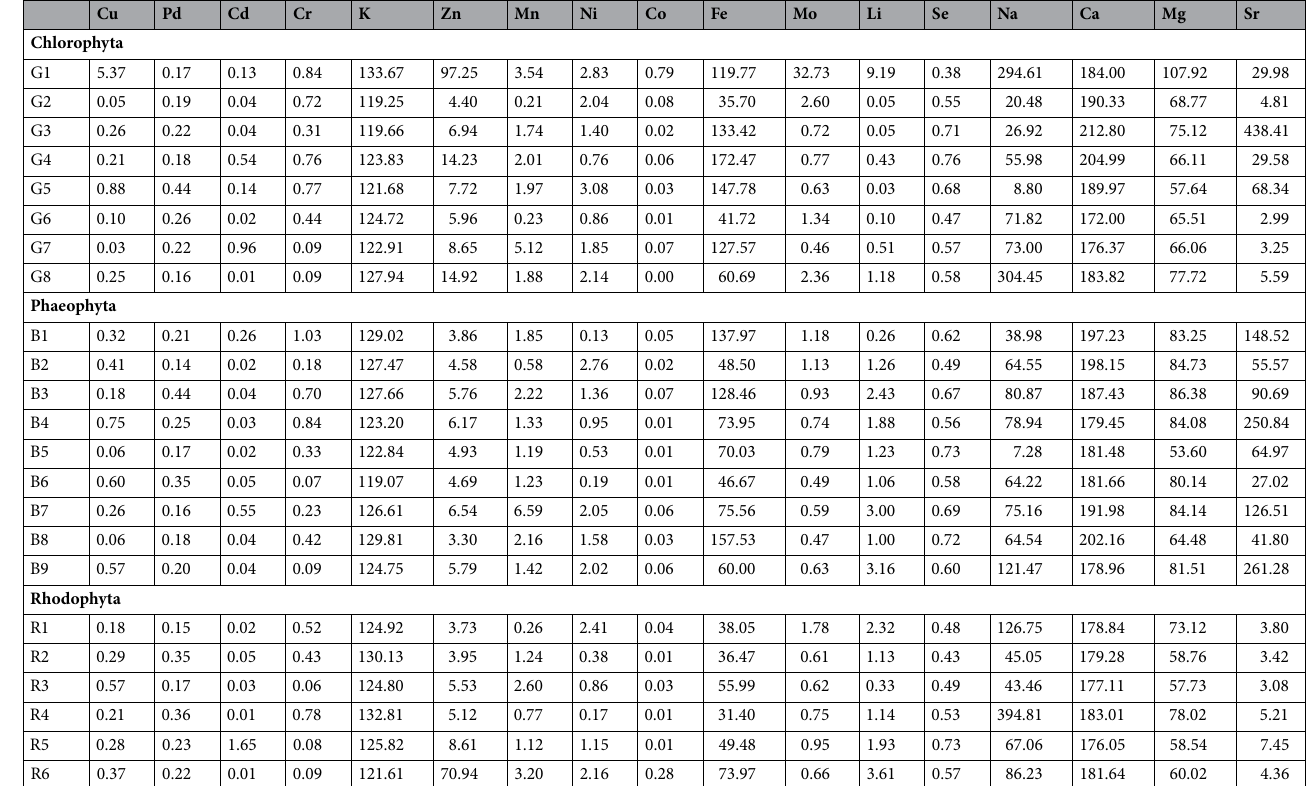
Table 6. The percentage as a mean value (mg/100 g) of mineral elements composition for each seaweeds species. (G1) Ulva lactuca , (G2) Caulerpa racemosa, (G3) Halimeda opuntin , (G4) Caulerpa racemosa , (G5)